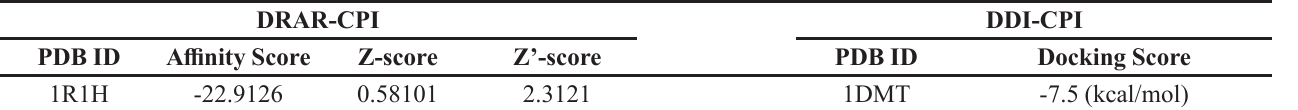
TABLE II - Results of the arteannuin-neprilysin interactome using DRAR-CPI and DDI-CPI